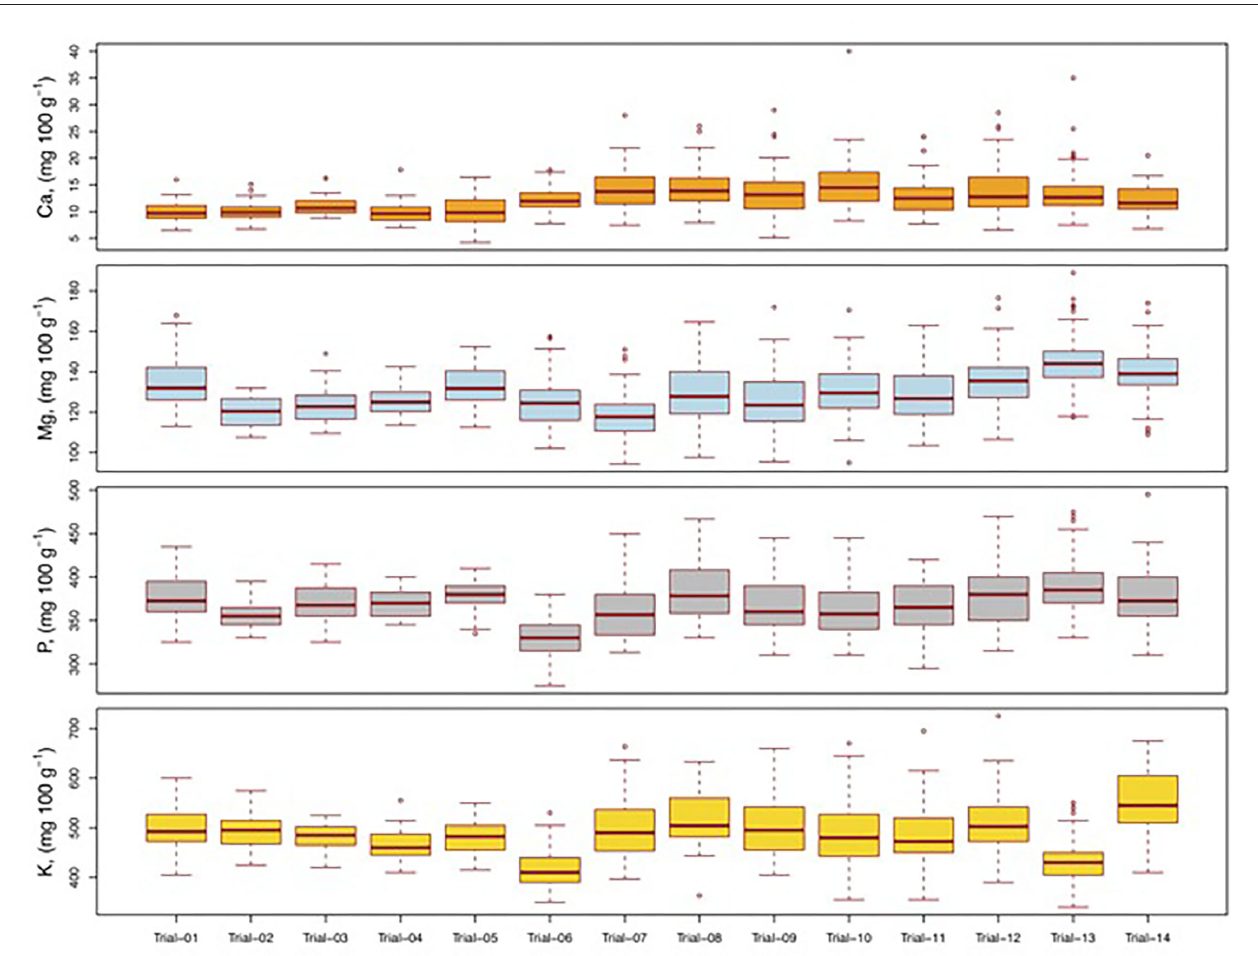
FIGURE 1 | Variability for potassium (K), phosphorus (P), magnesium (Mg), and calcium (Ca) in pearl hybrid trials (trial 1 to trial 6), inbred trials (trial 7 to trial 12 and trial 14), and germplasm accessions (trial 13) at the ICRISAT, Hyderabad, India.